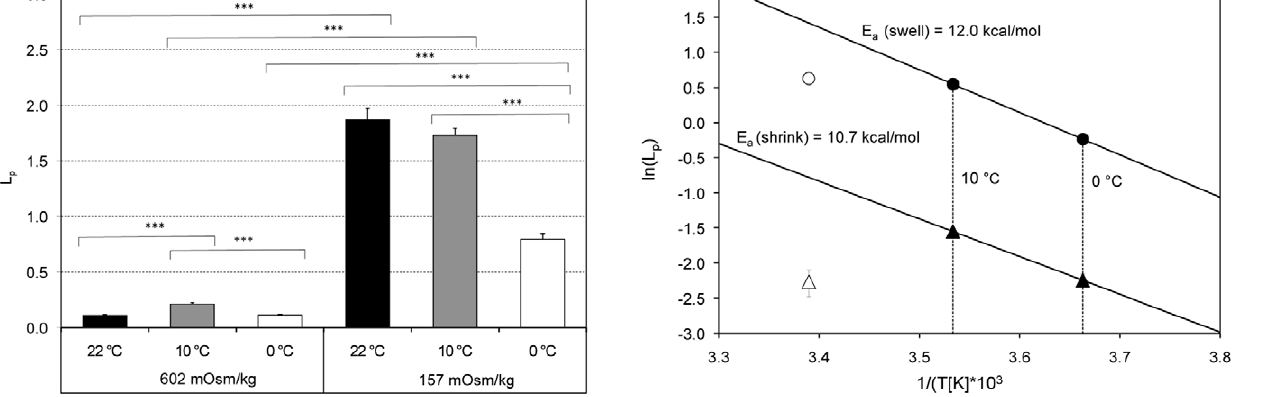
Figure 5. L p values (water permeability) obtained under hyper- and hypotonic conditions. The three bars to the left show the L p ’s under hypertonic conditions and the three bars to the right under hypotonic conditions. The differences between the two L p ’s determined at the same temperature are highly significant (p , 0.0001). That is true for all three temperatures. These differences strongly indicate rectification of the water flow; that is, the flow rate is different out of the cell than into the cell.